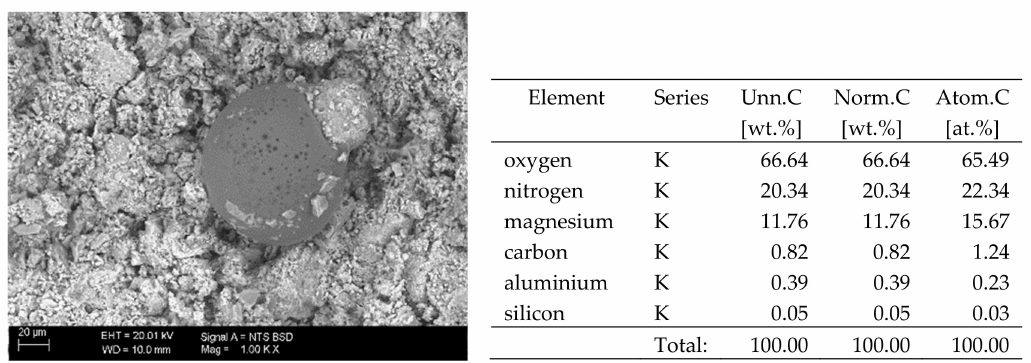
Figure 10. SEM image of the microstructure of Mg(NO 3 ) 2 crystals visible on the surface of the bricks tested; 1000 × magnification. Next to it is a screenshot an EDS analysis for presence of